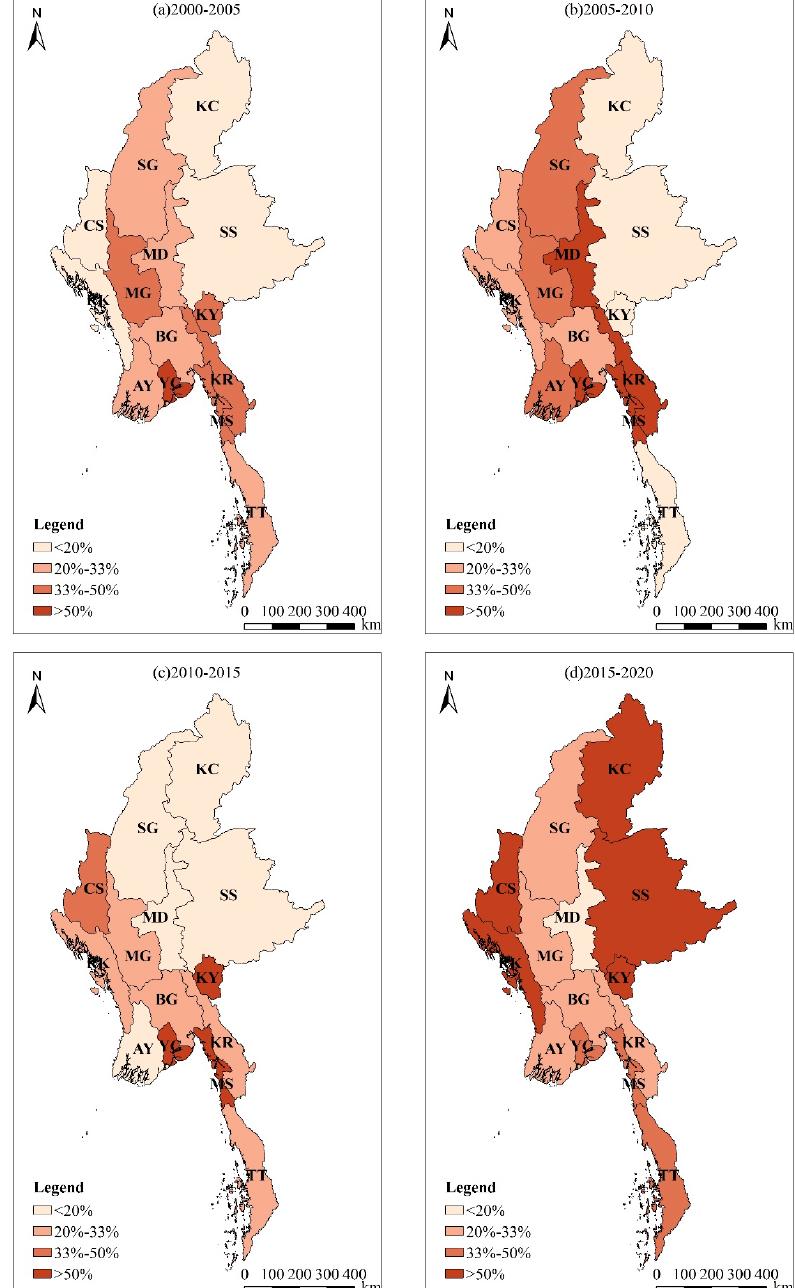
Figure 3. Change tendencies of LUC types of Myanmar during 2000–2020.